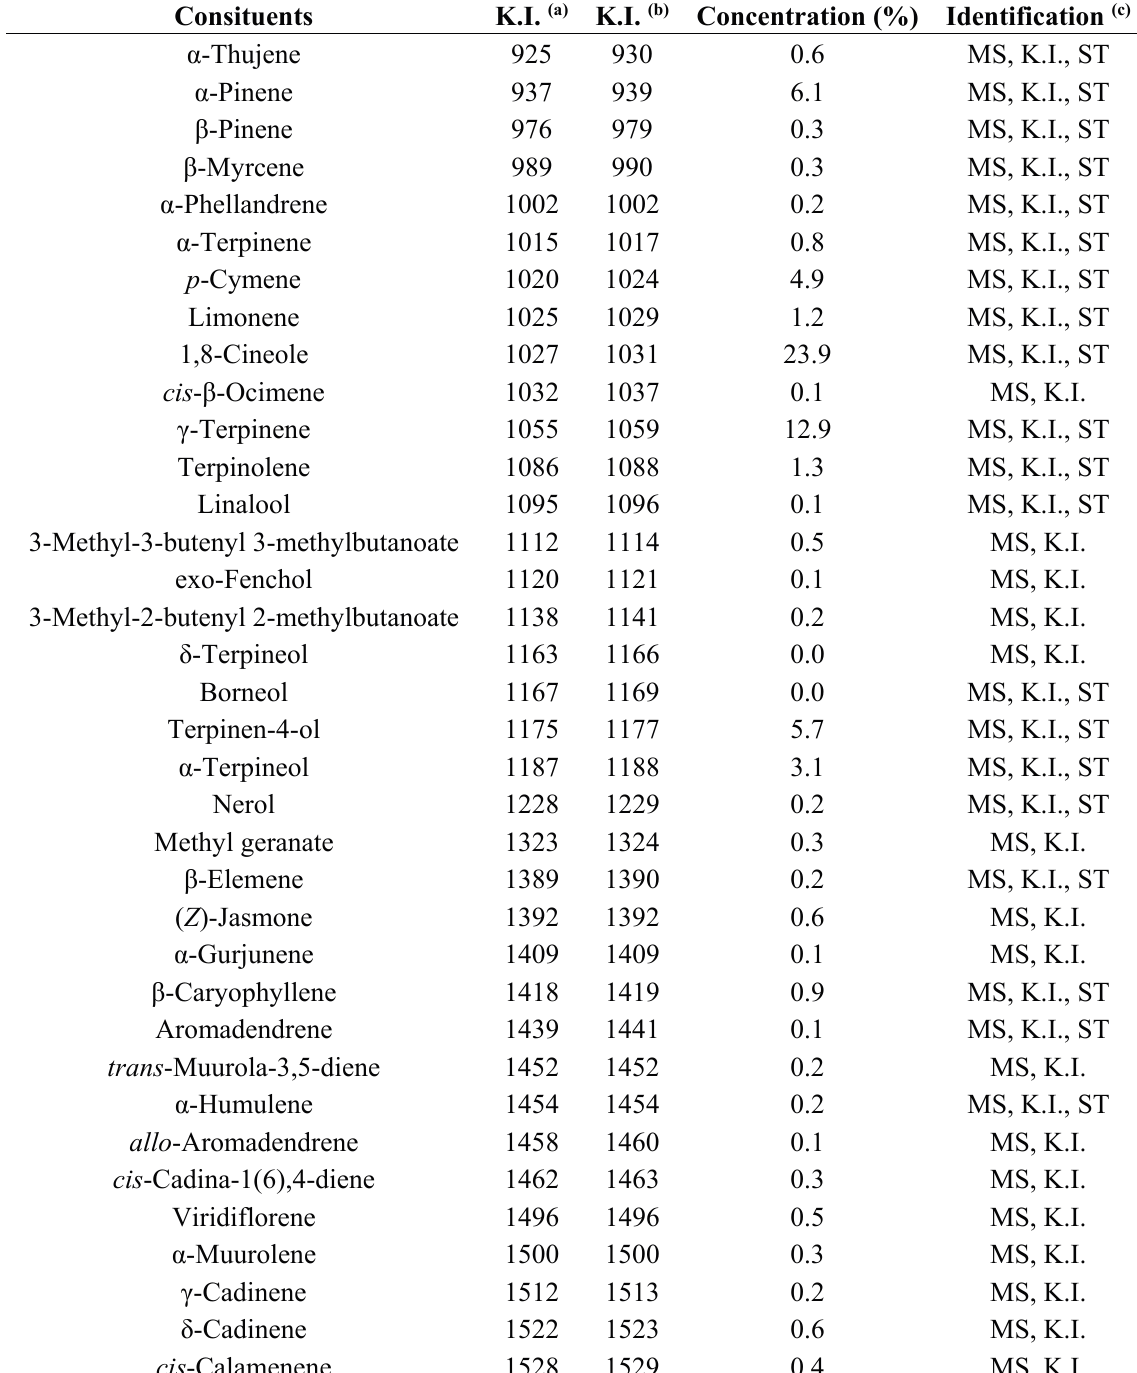
Table 1. Chemical composition of the flower oil from Eucalyptus camaldulensis